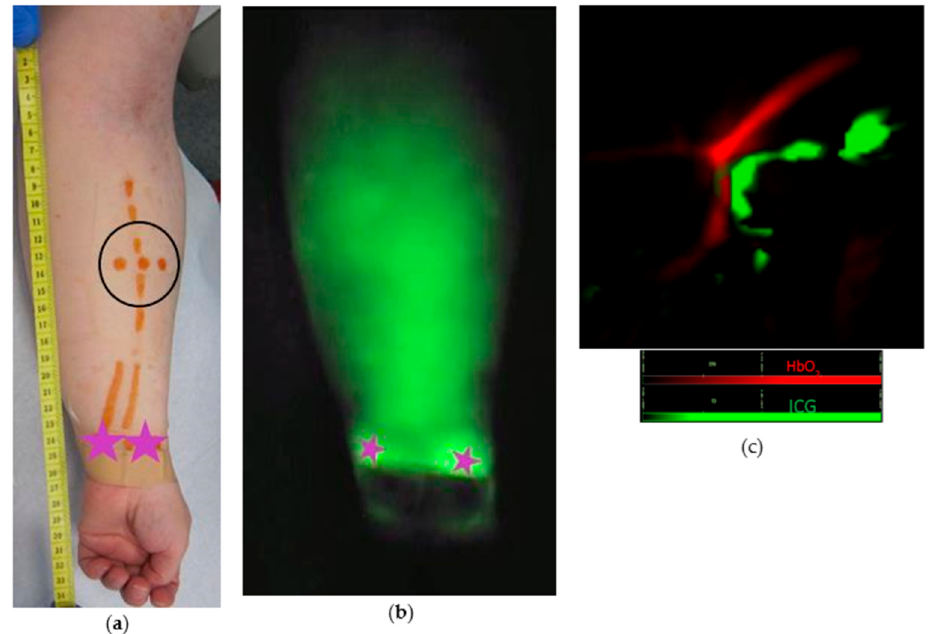
Figure 5. ( a ) Clinical image of patient 1 with upper limb lymphedema. ( b ) Diffuse dermal backflow pattern after ICG injection (purple stars) ( c ) MSOT identification of lymphatic vessel (green) and vein (red) in the area of diffuse dermal backflow. The location of these vessels identified by MSOT is marked on the skin by orange dots (see within black circle in a).